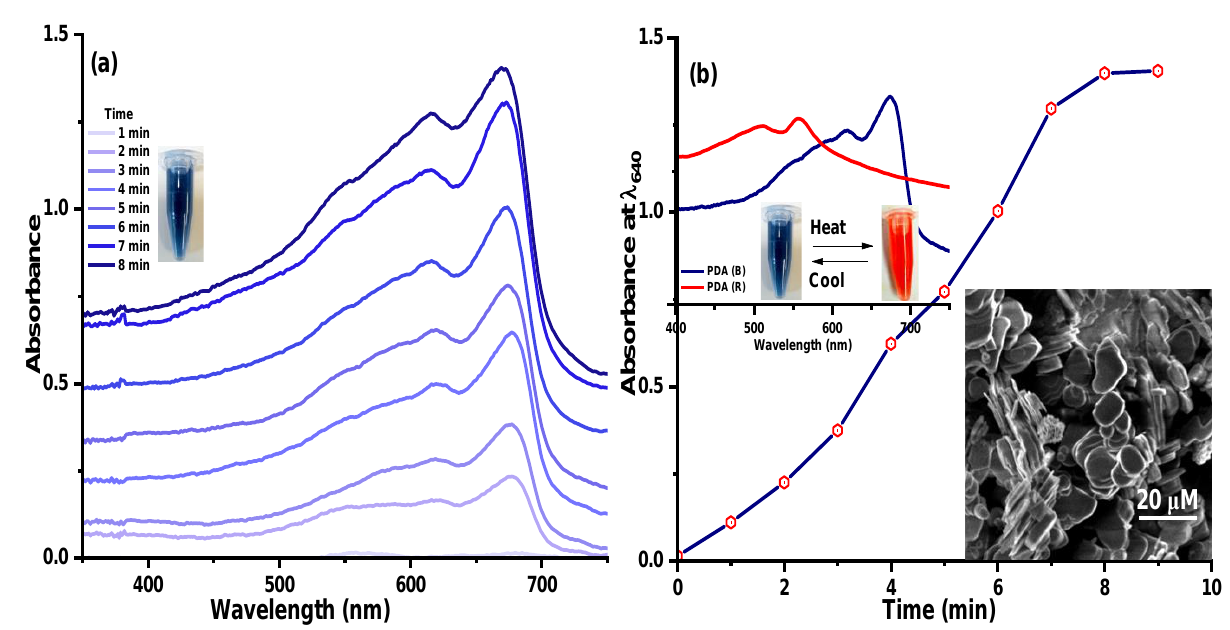
Figure 8. Absorption spectra of ( a ) PDA-ZnO, ( b ) plot of A 670nm vs. time. Inset thermochromic shift at 65 °C and PDA nanosheets micrograph.